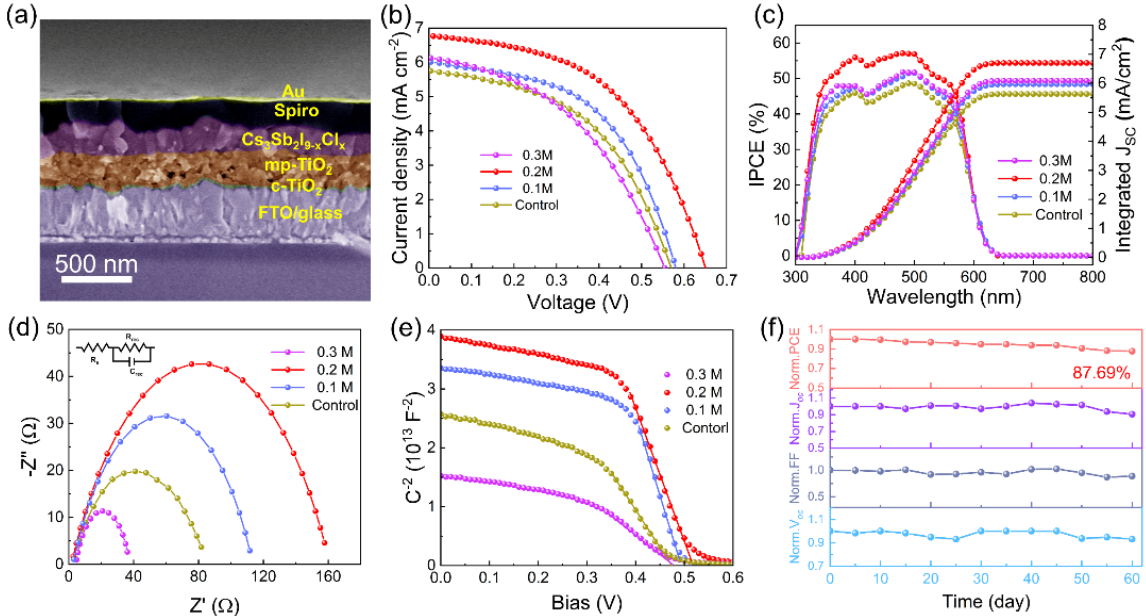
Figure 5. ( a ) Cross − section SEM image of the device. Comparison of the fabricated Cs 3 Sb 2 I 9 − x Cl x films with different amounts of TU: ( b ) J–V curves; ( c ) EQE and integrated current density; ( d ) Nyquist plots; ( e ) Mott–Schottky curve. ( f ) Long − term stability of non − encapsulated PSCs in N 2 environment